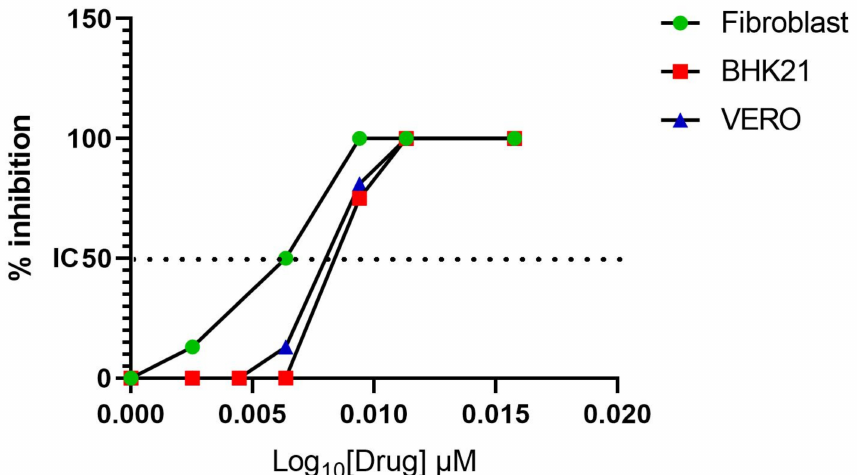
Figure 2. Favipiravir inhibits MAYV in cell culture. Favipiravir was introduced in medium culture 1 h after MAYV exposure of the cells Vero-6, BHK-21 and primate tendon primary fibroblasts at a MOI of 0.005 and 0.002, respectively. Favipiravir MAYV Inhibitory Concentration 50% was obtained on two independent assays and in octoplicates for each dilution of the drug